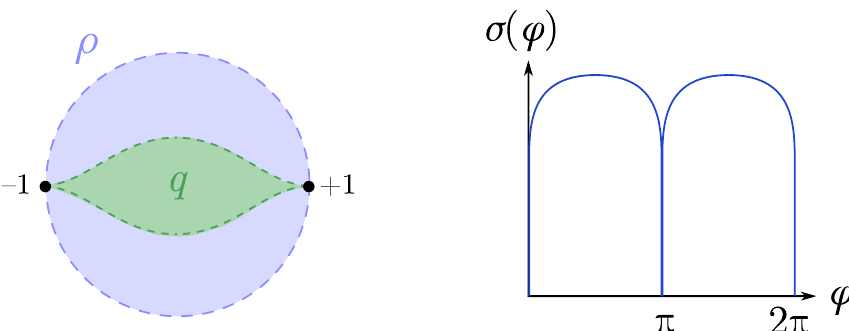
Figure 13. Left. Relation between the radial ρ variable and the nome q . Right. The real part of − log q as a function of Lorentzian